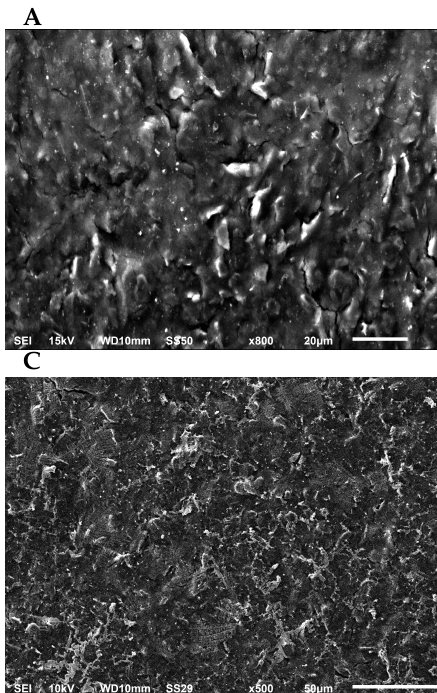
Figure A1. SEM images of a bare rGO electrode ( A ), an aminated rGO electrode ( B ) and aminated electrodes after incubation in the antibody ( C